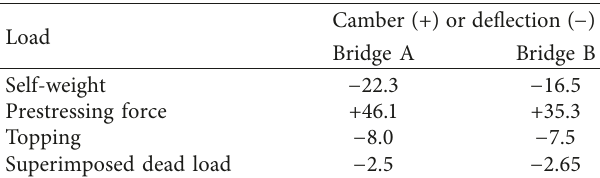
Table 7: Elastic camber and deflection of bridges A and